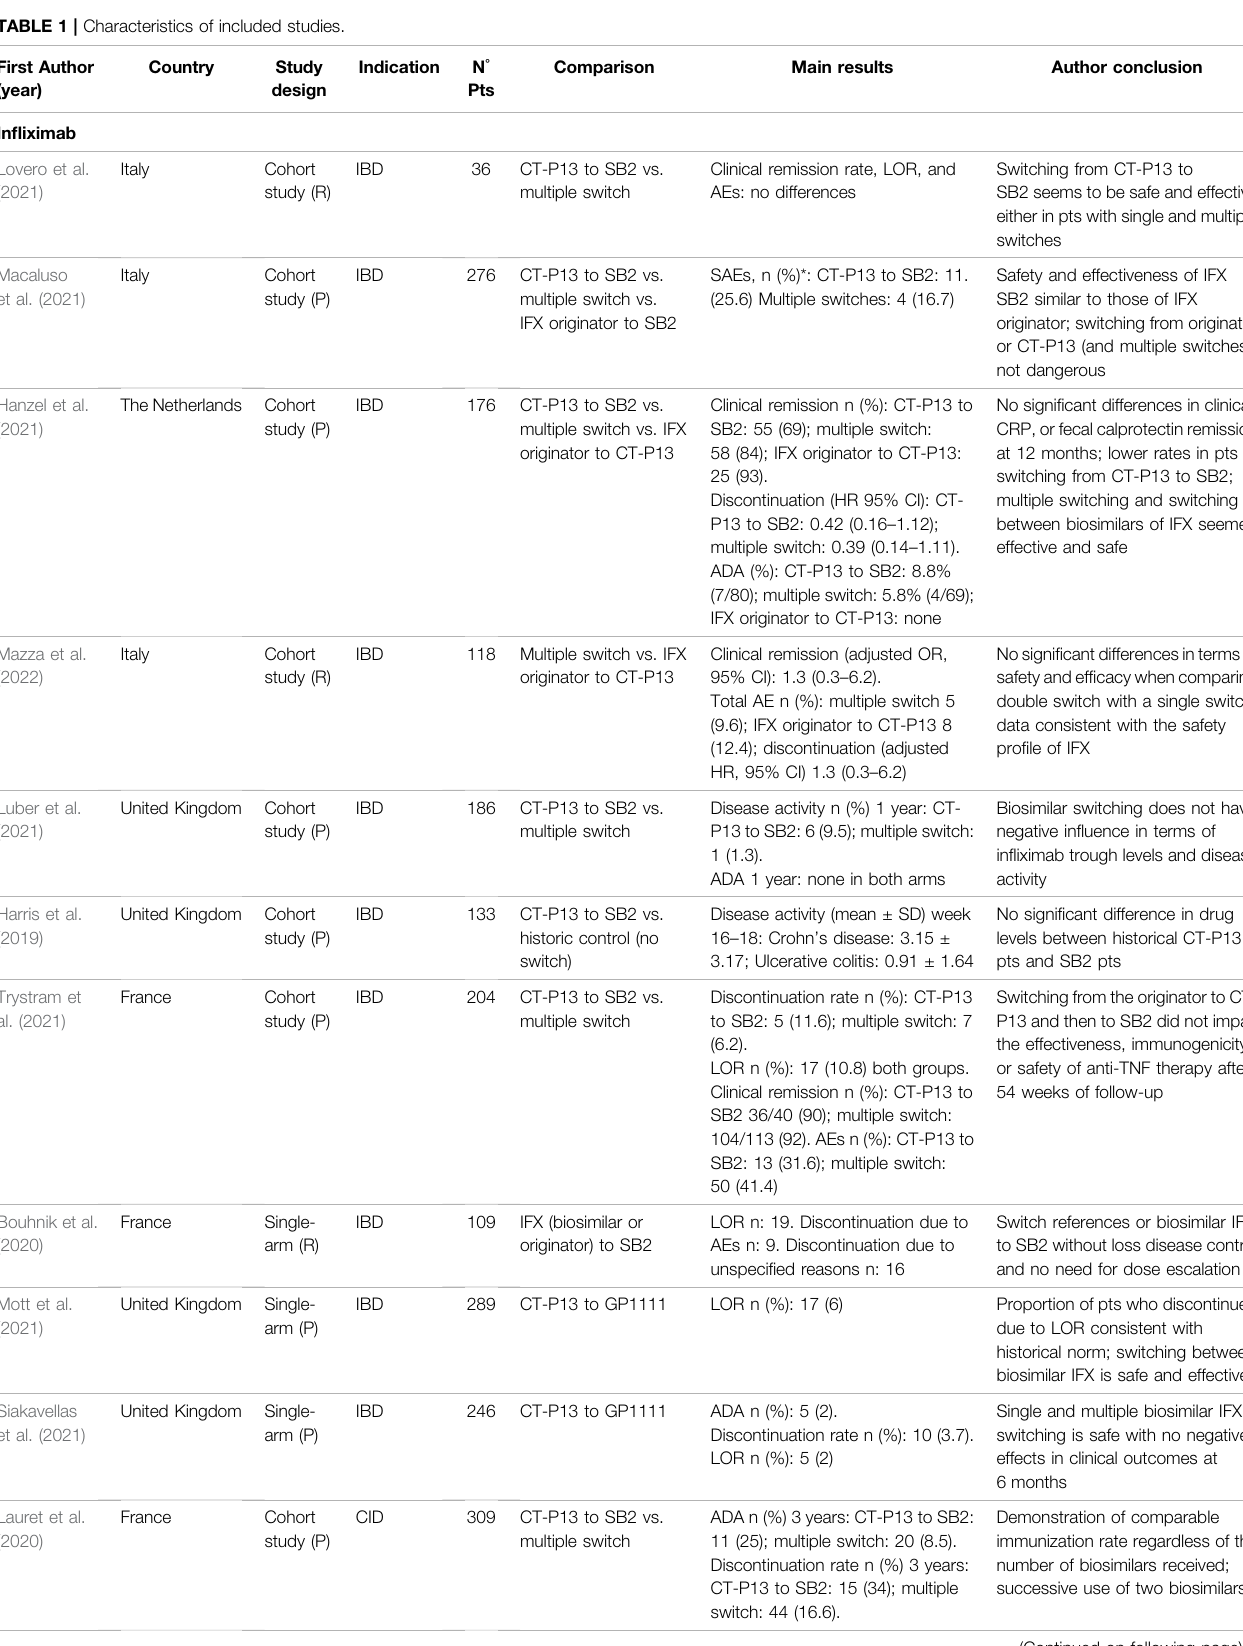
TABLE 1 | Characteristics of included